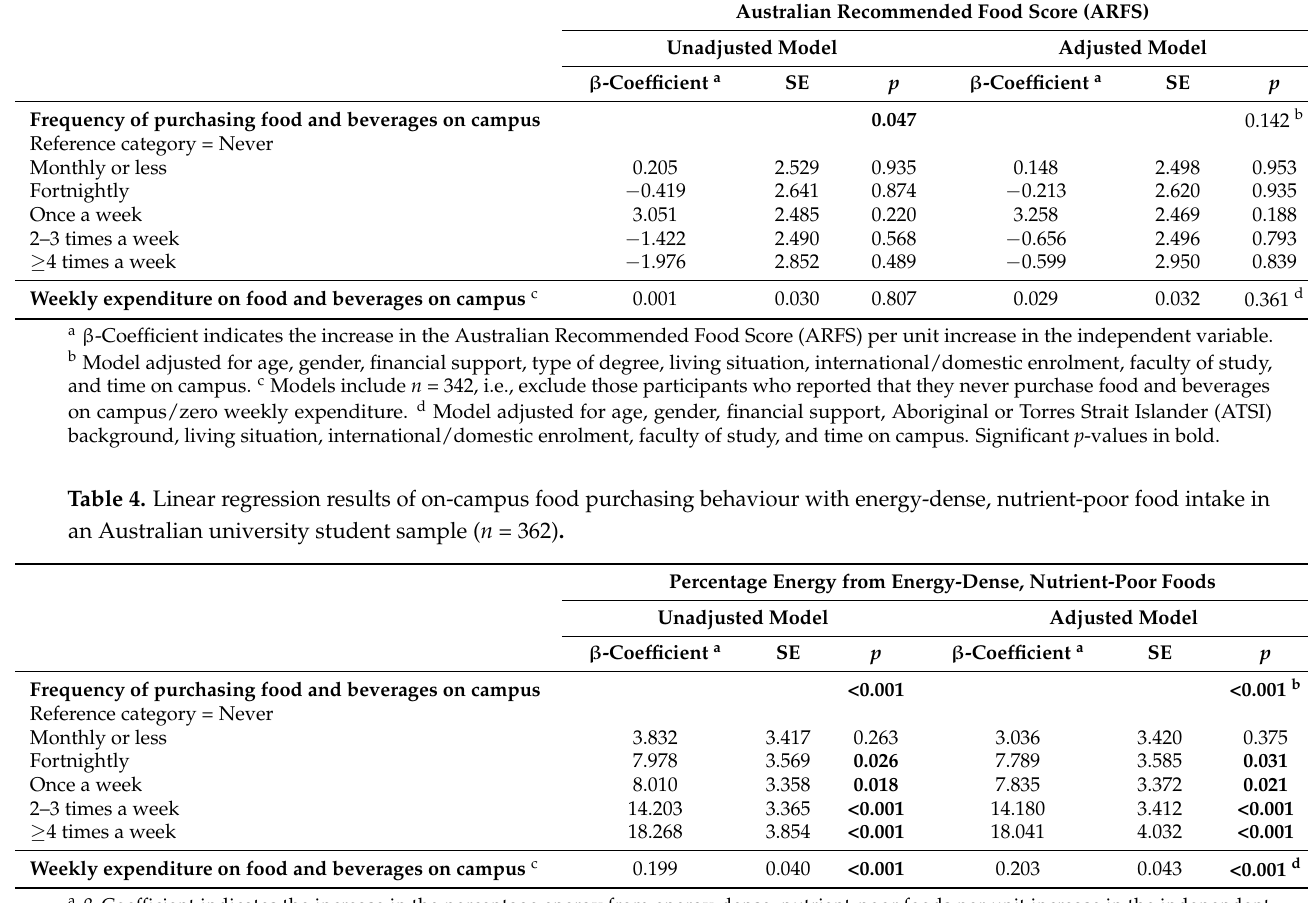
Table 3. Linear regression results of on-campus food purchasing behaviour with diet quality in an Australian university student sample ( n = 362).